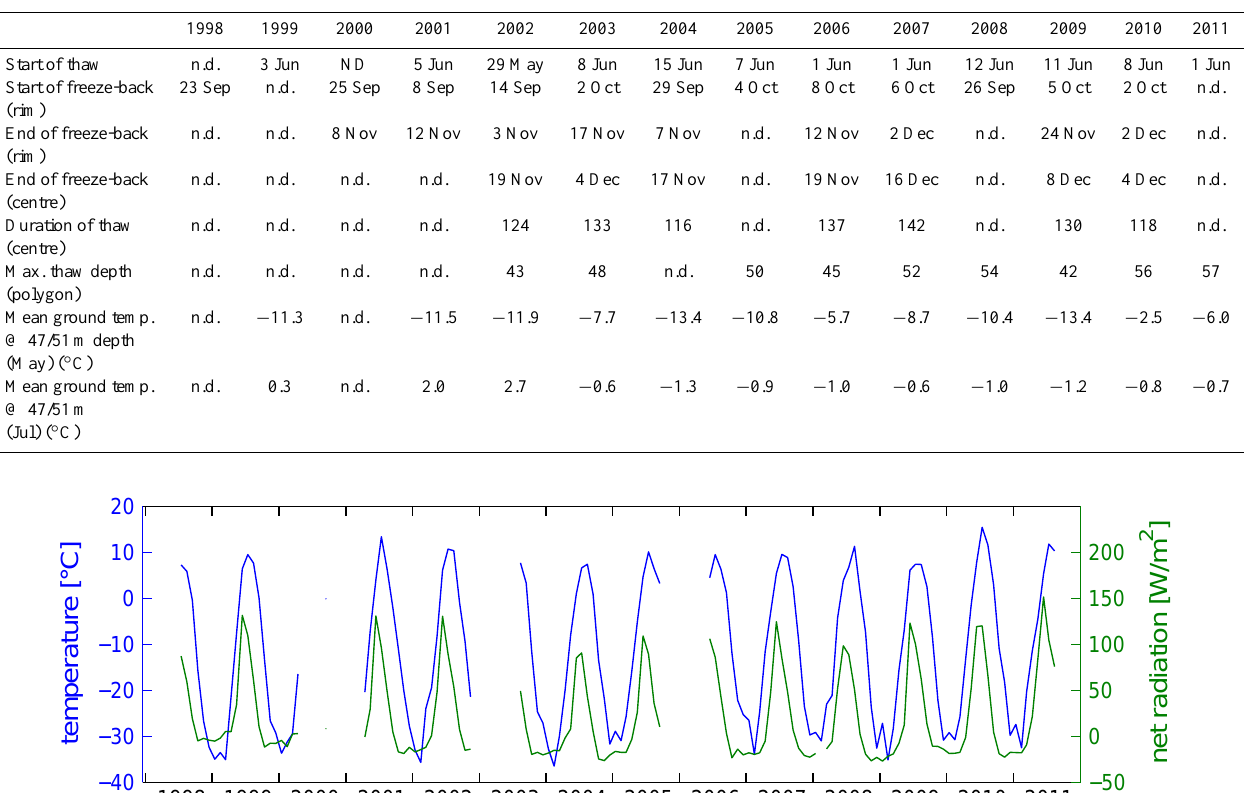
Table 6. Duration of active layer thaw and freeze of polygon rim and centre (days) and thaw depths (cm), for the years 1998–2011. The differences between the water saturated centre and the dry rim are only available from 2002 to 2011. The start of freeze-back was determined as the time when temperatures in all thawed layers had fallen to 0 ◦ C. The end of freeze-back was determined as the time when the volumetric water content (using Time Domain Reflectometry) reached, and remained at, its minimum. Note that the soil instrumentation was moved in 2002. Thaw depths in 2007 and 2009 were determined in mid-August, and for all other years at the end of August.